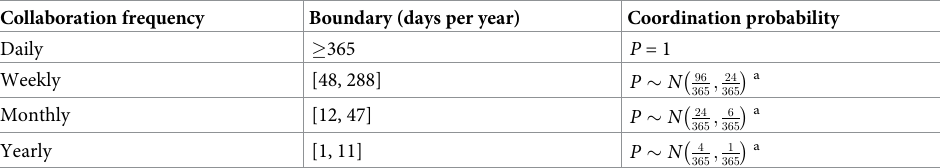
Table 2. Converted daily coordination probabilities between organizations.